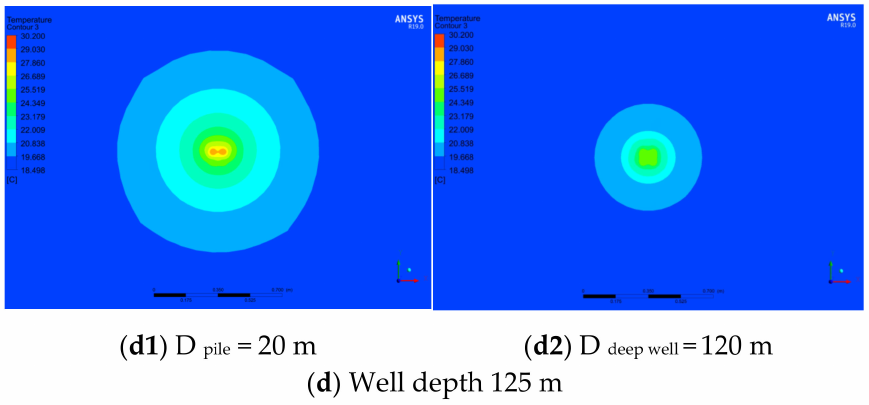
Figure 5. Cloud diagram of temperature distribution.